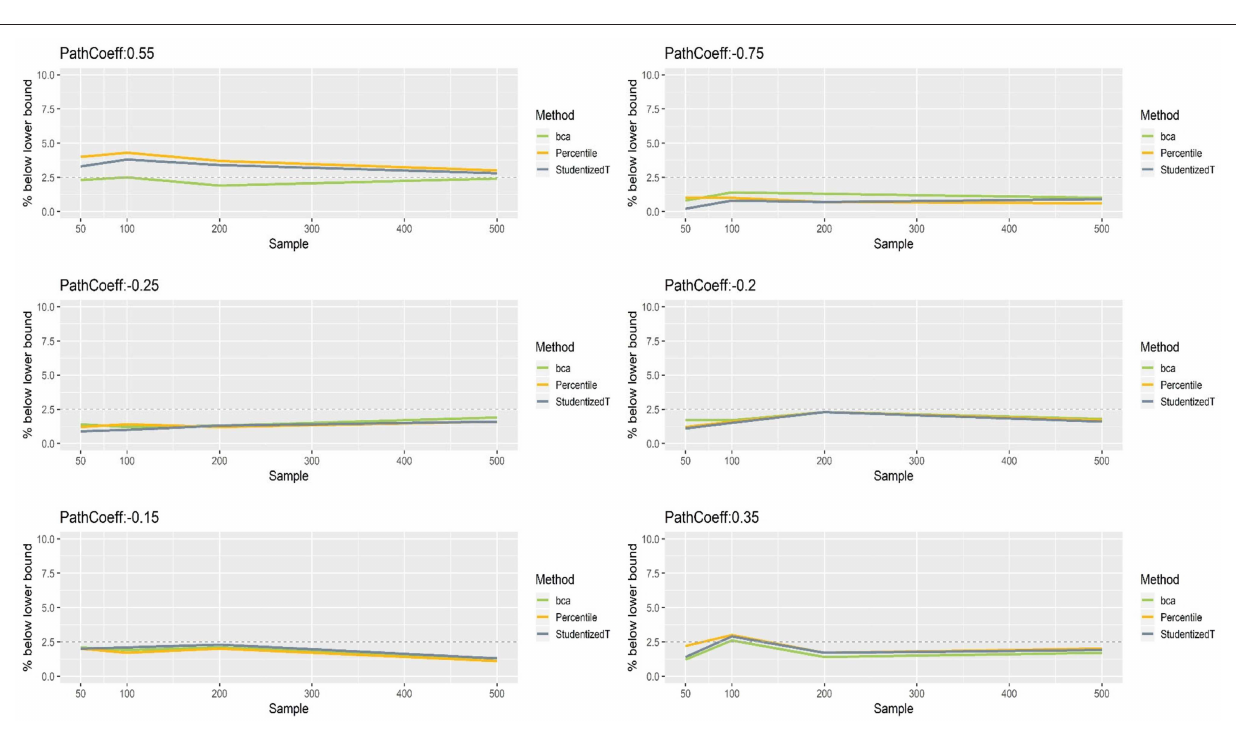
Frontiers in Psychology |